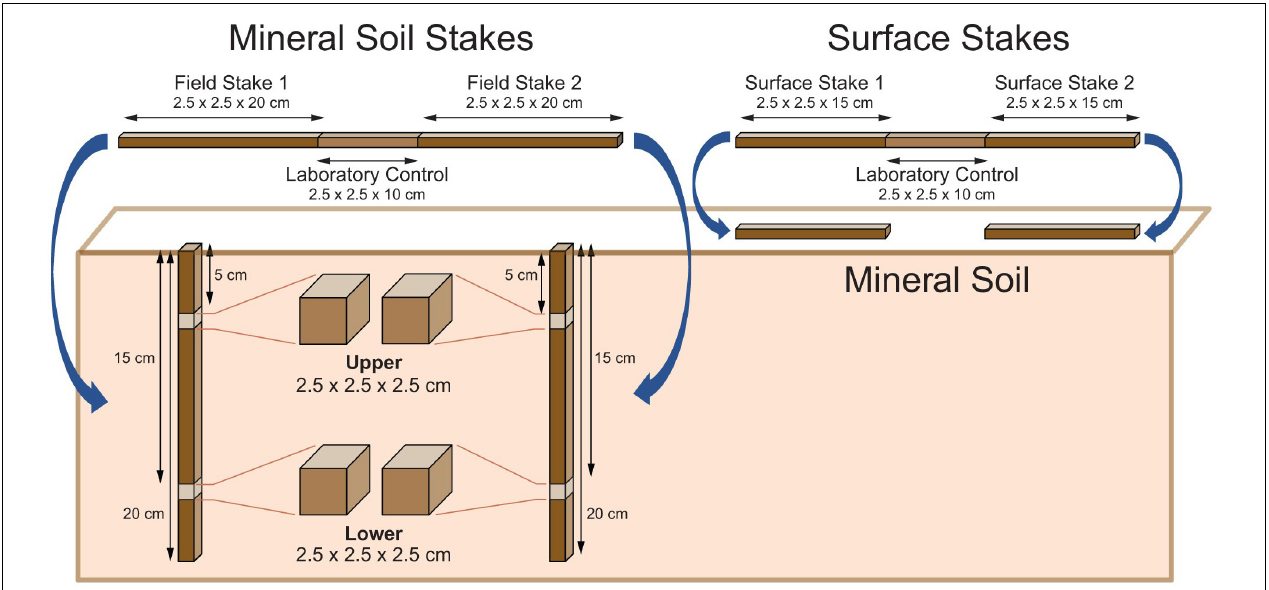
FIGURE 2 | Fabrication, cutting, and placement of surface and mineral soil stakes used in the Cedar Fire study.